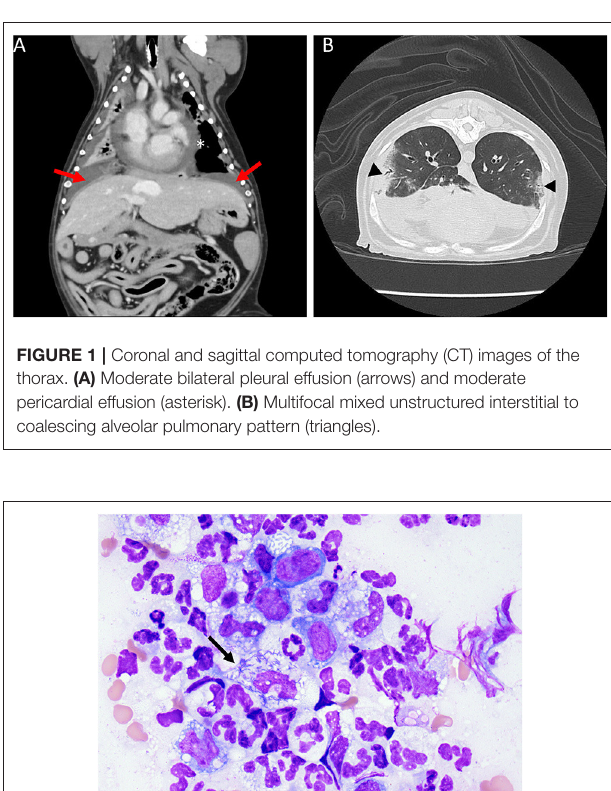
A subtotal pericardiectomy was performed with a 7 cm × 4 cm